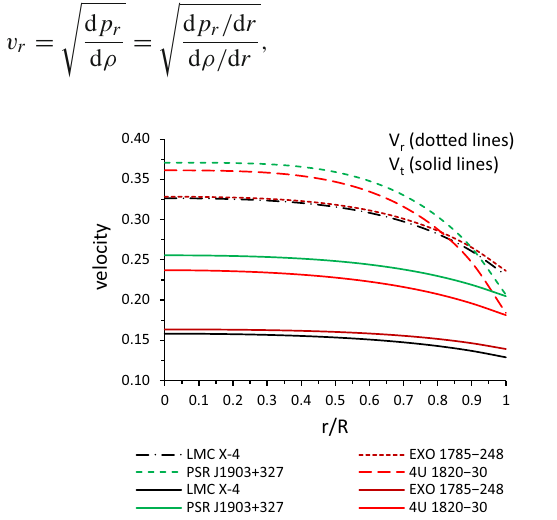
Fig. 5 Behaviour of radial velocity, v r , ( dotted line ) and tangential velocity, v t , ( solid line ) vs. fractional radius r / R for LMC X-4, EXO 1785-248, PSR J1903+327 and 4U 1820-30. For plotting this figure we have employed data set values of physical parameters and constants which are the same as used in Fig.